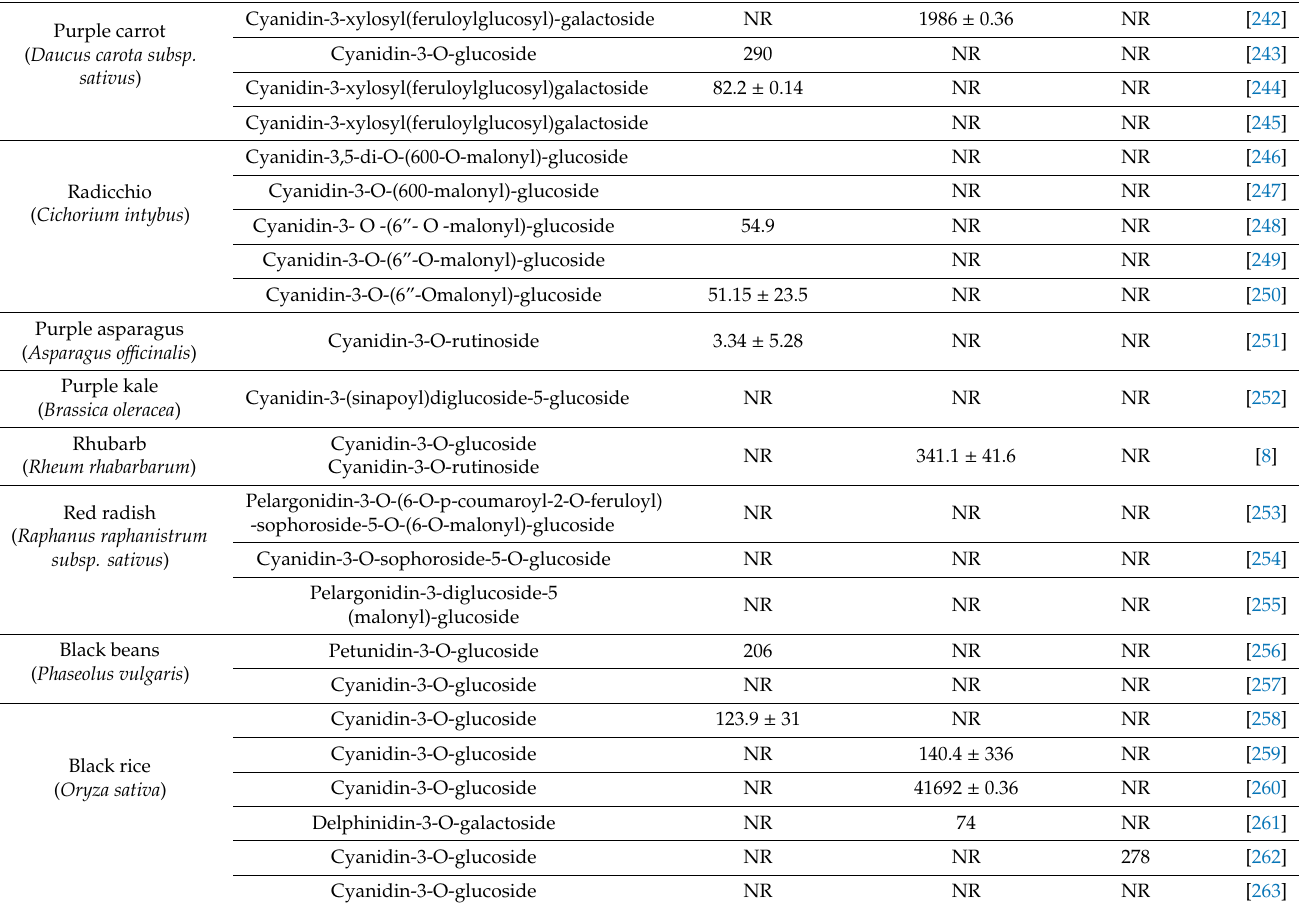
Purple carrot ( Daucus carota subsp. sativus )